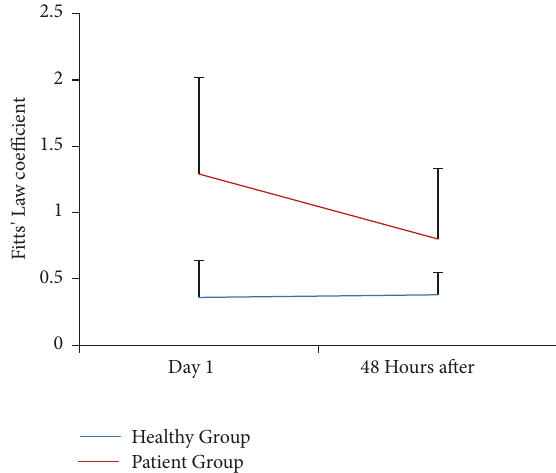
Figure 4: Interaction between the referential coefficient and the coefficient of each individual during the tapping task. Intra- and intergroup differences between Day 1 and 48 hours after treatment ( p < 0.05). Lines represent the means for each